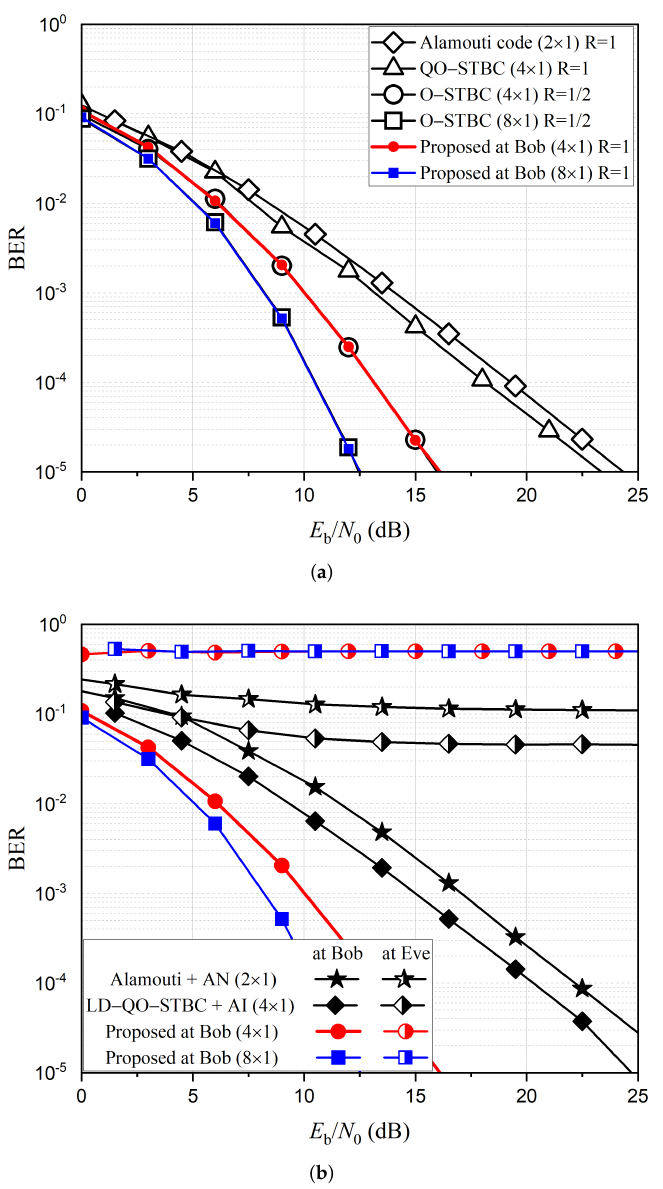
Figure 2. BER performance comparison for various STBC schemes. ( a ) without PLS. ( b ) with